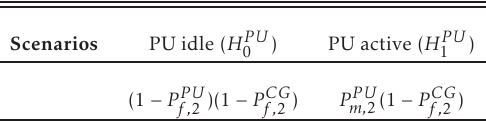
Table 3. Possible Transmission Probability for CGN